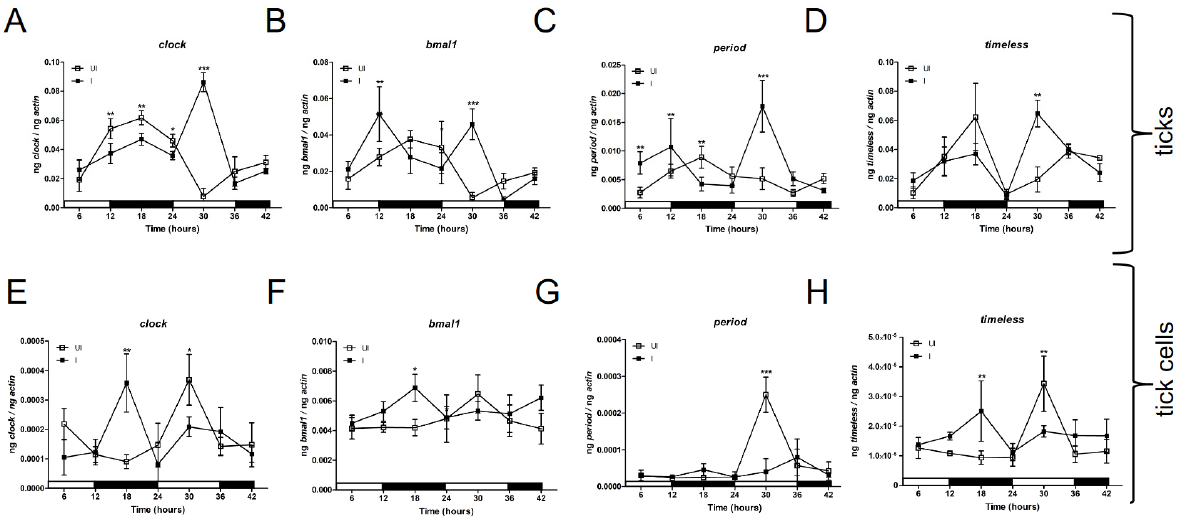
Figure 3. Anaplasma phagocytophilum perturbs oscillation of expression of circadian genes in unfed nymphs and tick cells. QRT-PCR analysis showing oscillating expression of circadian genes clock ( A , E ); bmal1 ( B , F ); period ( C , G ); and timeless ( D , H ) in unfed uninfected (open squares) or A. phagocytophilum - infected (closed squares) nymphs ( A – D ) and tick cells ( E – H ) upon exposure to 12 h light: 12 h dark conditions. Uninfected and A. phagocytophilum -infected ticks ( n = 5) and tick cells ( n = 6) were collected at indicated timepoints. The Y-axis indicates relative mRNA transcripts normalized to tick-beta actin levels and the X-axis represents the time points in hours. Data are presented as the mean ± SD using relative quantification normalized to tick beta-actin mRNA levels. Light and dark phases are indicated as white and black bars, respectively, on the X-axis. Statistical significance between the samples collected at indicated time points was calculated using One way ANOVA analysis and p < 0.05 was considered as significant. * p < 0.05, ** p < 0.01 and *** p <